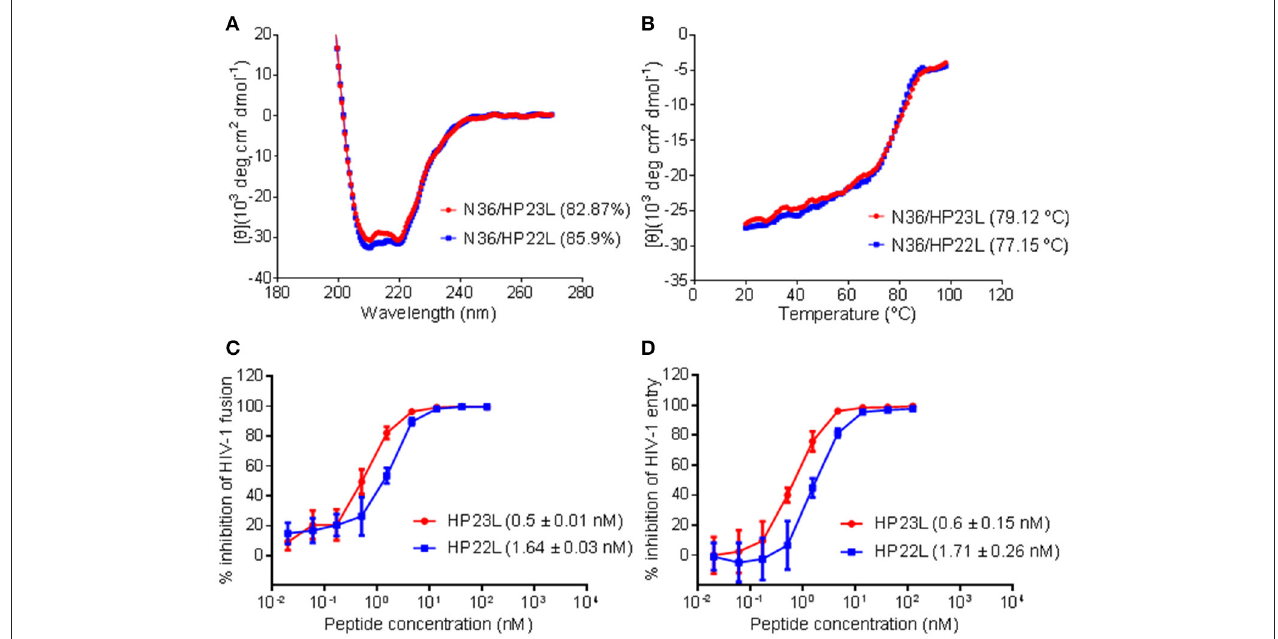
FIGURE 5 | Biophysical and functional characterization of the extra N-terminal glutamic residue of HP23L. The α -helicity (A) and thermostability (B) of HP23L- and HP22L-based 6-HBs were compared by CD spectroscopy. The final concentration of each peptide in PBS was 10 µ M. The % helical content and T m values are shown in parentheses. The inhibitory activities of HP23L and HP22L on HIV-1 Env-mediated cell-cell fusion (C) and pseudovirus entry (D) were measured by DSP assay and single cycle infection assay, respectively. The experiments were repeated 3 times, and mean IC 50 values are shown in parentheses.